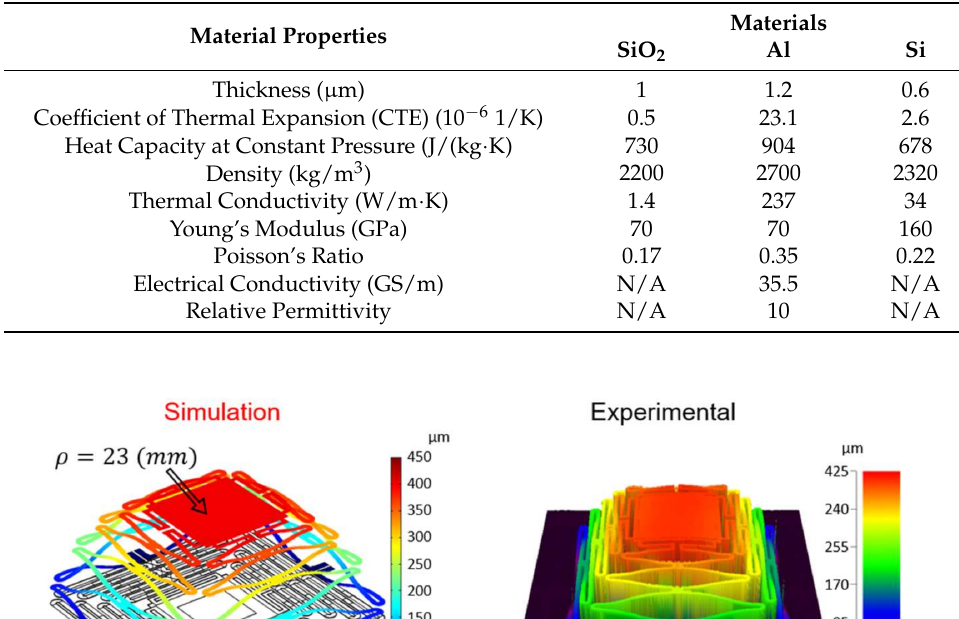
Table 2. Material layers properties of the model structure used in the COMSOL 5.5 model.